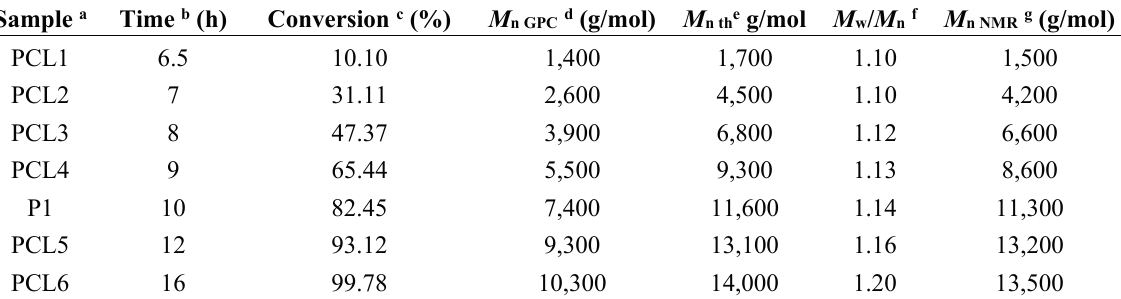
Figure 2. Dependence of the molecular weights and the molecular weight distributions on the monomer conversions for the ring-opening polymerization of CL. The polymerization conditions are same as in Figure 1. “ ■ ” means the molecular weight ( M n GPC ) of PCL with monomer conversion, and “ ○ ” means the molecular weight distribution ( M w / M n ) of PCL with monomer conversion. Table 1. Characteristics of poly( ε -caprolactone)s